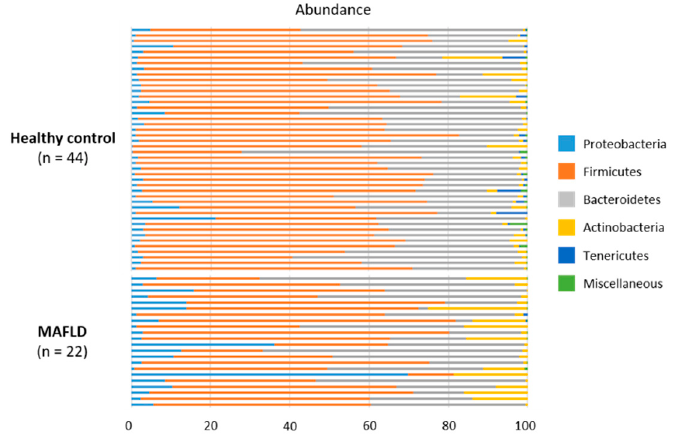
Figure 2. Relative proportion of phylum and family of gut microbiomes in MAFLD and healthy controls.